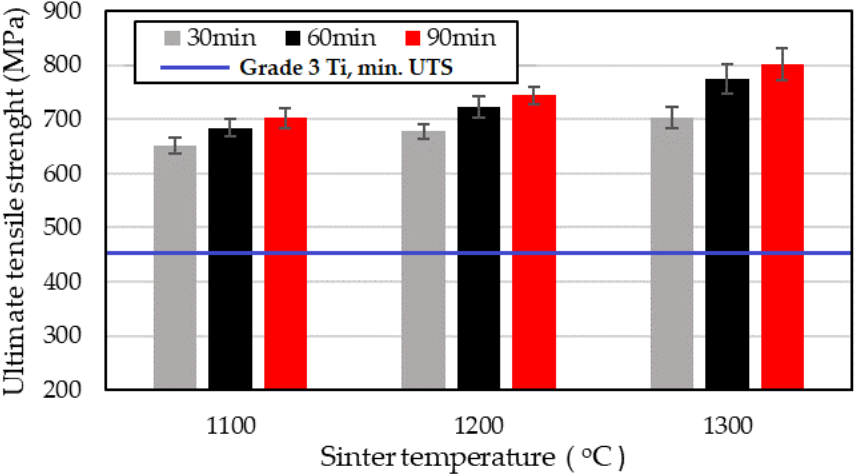
Figure 12. Ultimate tensile strength of the sintered titanium strips.